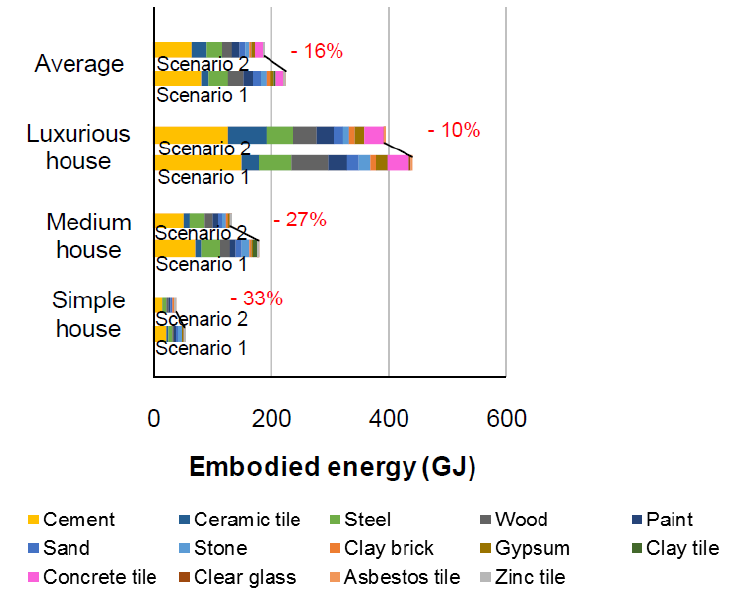
Figure 6. Embodied